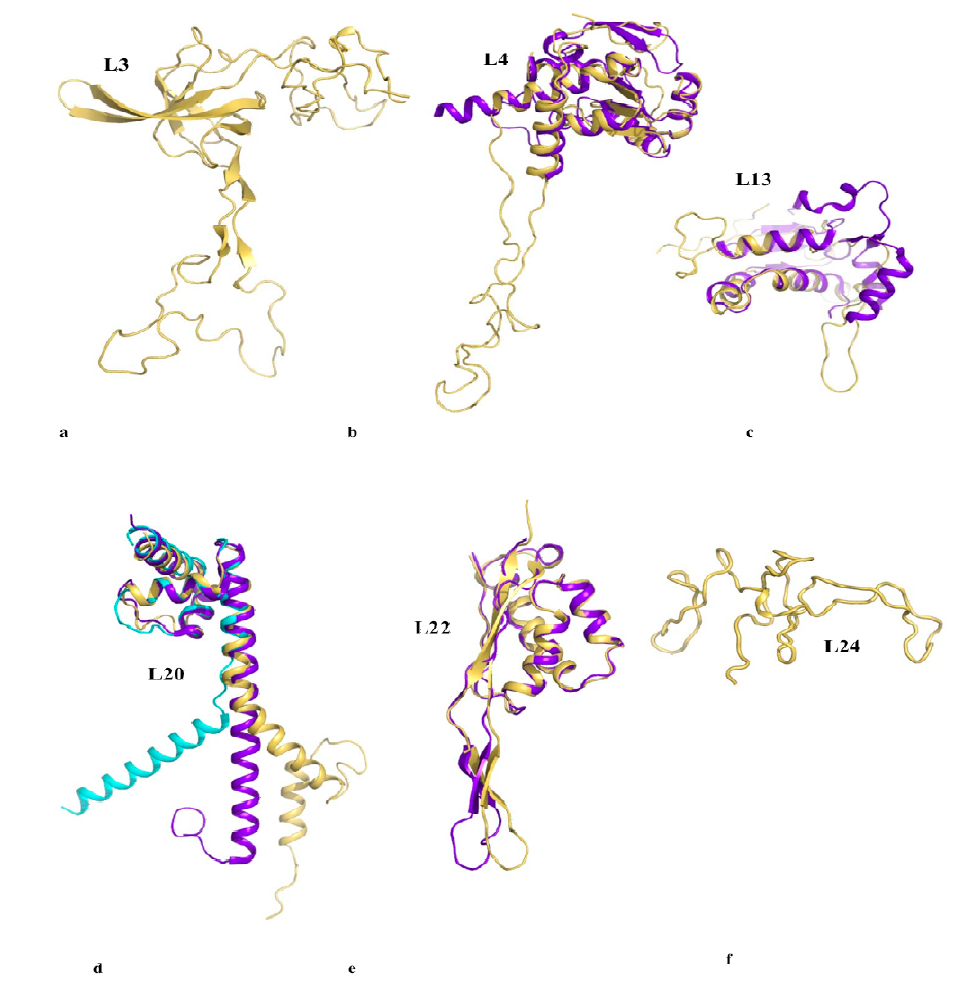
Figure 2. Comparison of the six proteins that are essential for the early steps of the assembly of the 50 S subunit of the eubacterial ribosome. a. L3. b. L4. c. L13. d. L20. e. L22. f. L24. The structures of the proteins bound to the ribosome are depicted in yellow and the free forms, when available, are depicted in purple blue. In the crystal structure of the free L20, two folded states coexist within the unit cell: a partially unfolded form (cyan) and a folded form (purple blue) (see also Figure